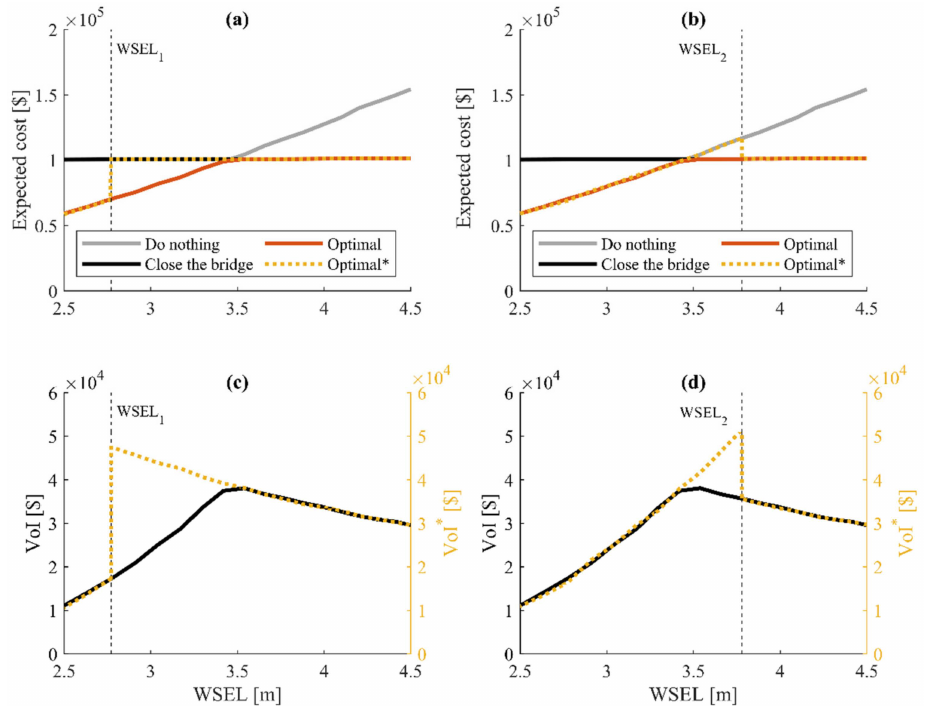
Figure 2. Flood emergency management. Results of the VoI analysis as a function of the WSEL for different decision scenarios: ( a ) Results of the Prior analysis for Scenarios 1 and 2a; ( b ) Results of the Prior analysis for Scenarios 1 and 2b; ( c ) VoI for Scenarios 1 and 2a; ( d ) VoI for Scenarios 1 and